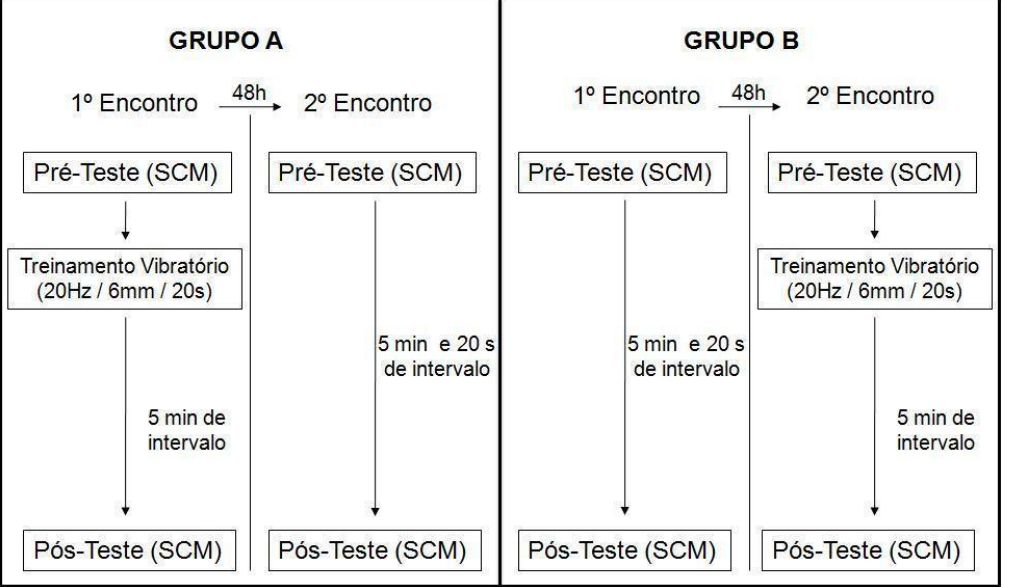
Figura1. Procedimentos do